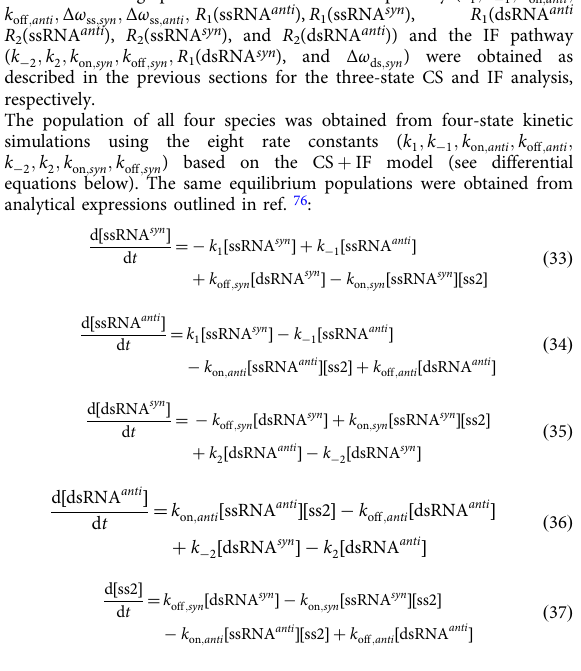
respectively. 2. The population of all four species was obtained from four-state kinetic simulations using the eight rate constants ( k 1 ; k (cid:1) 1 ; k on ; anti ; k off ; anti ; k (cid:1) 2 ; k 2 ; k on ; syn ; k off ; syn ) based on the CS + IF model (see differential equations below). The same equilibrium populations were obtained from analytical expressions outlined in ref. 76